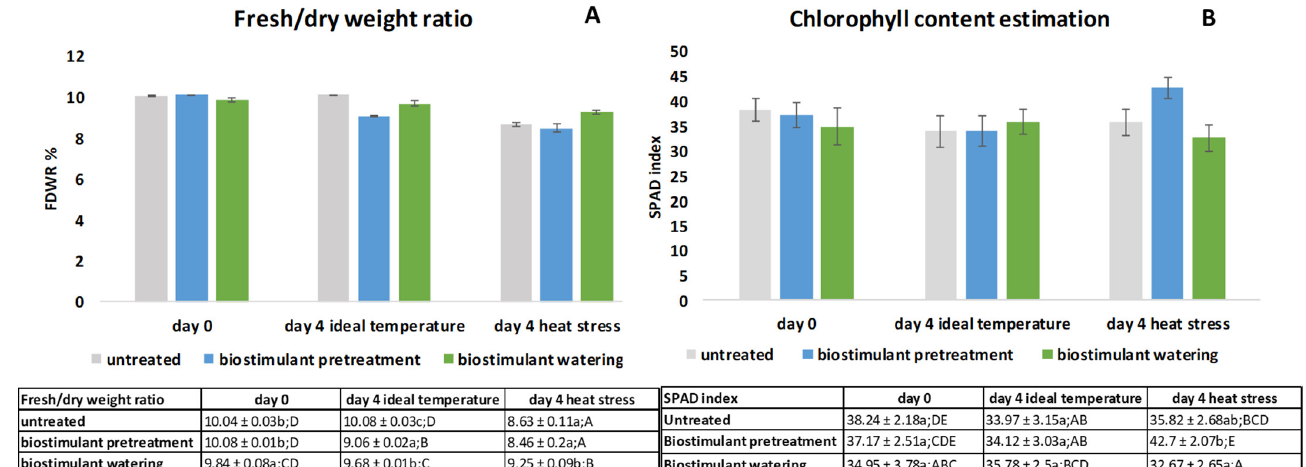
Figure 1. ( A ) Fresh/dry weight ratios ( n = 3) and ( B ) chlorophyll content estimation ( n = 10) of wheat leaves grown for 4 days under ideal and heat-stressed conditions at the same time subjected to biostimulant pretreatment or biostimulant watering. The same letters represent non-significant differences within each treatment ( p < 0.05). Upper-case letters refer to the time effect, whereas lower-case letters refer to the effect of biostimulant treatment within one sampling